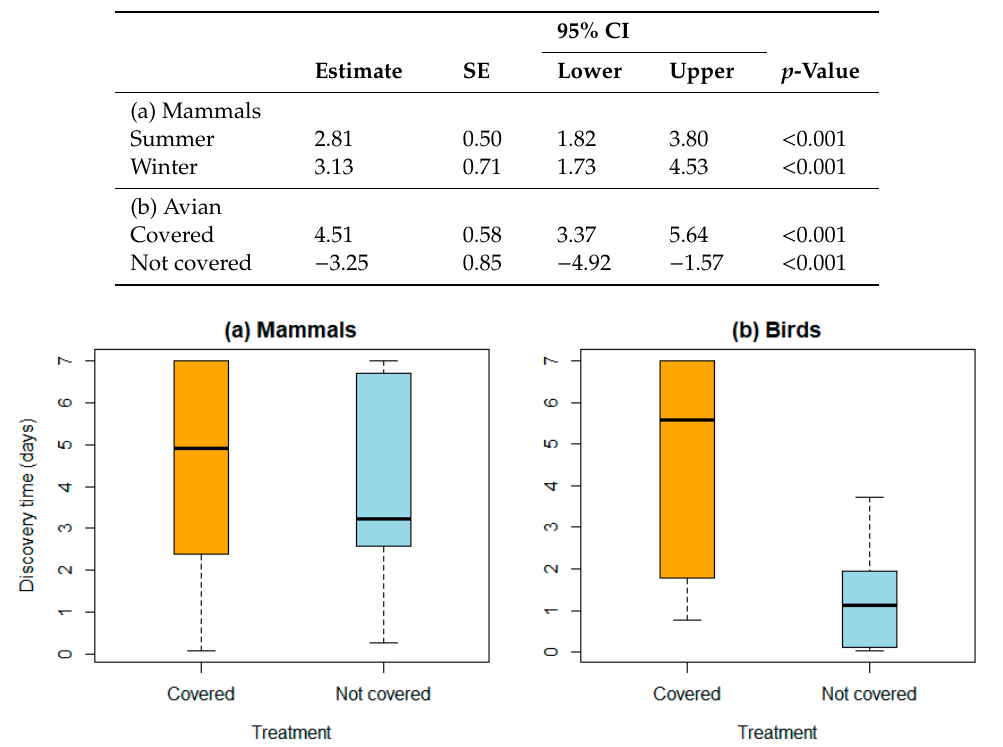
Figure 2. Box plots showing the effect of covering video-monitored experimentally-deployed roe deer carcasses on time to discovery (in days) for ( a ) mammalian, and ( b ) avian scavengers in South-Eastern Norway.